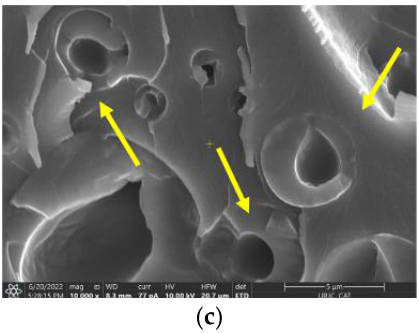
Figure 5. SEM images of the fracture surface of epoxy blends with ( a ) 5, ( b ) 10 and ( c ) 15 wt.% PCL, where the yellow arrows denote the presence of large PCL domains.